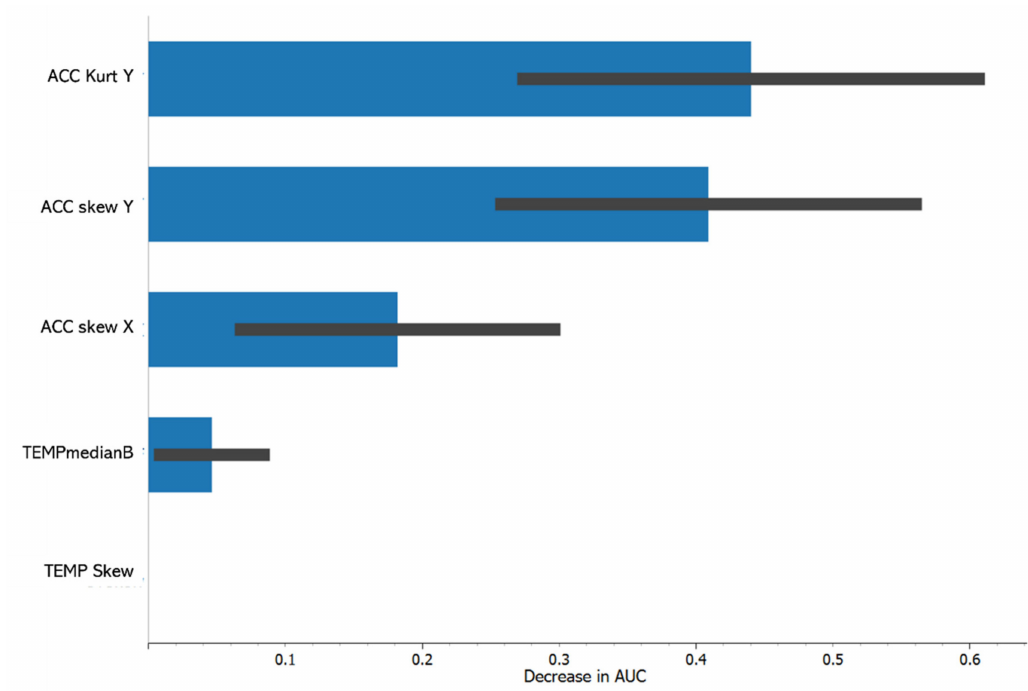
Figure 2. Relative importance of the five features in terms of the average decrease in the AUC value for the Study 2 logistic regression model associated with randomly shuffling a feature in the data. 1000 random shuffles were used for each feature. Mean (blue bar) and standard deviation (black line) for reduction in AUC across the 1000 random shuffles is